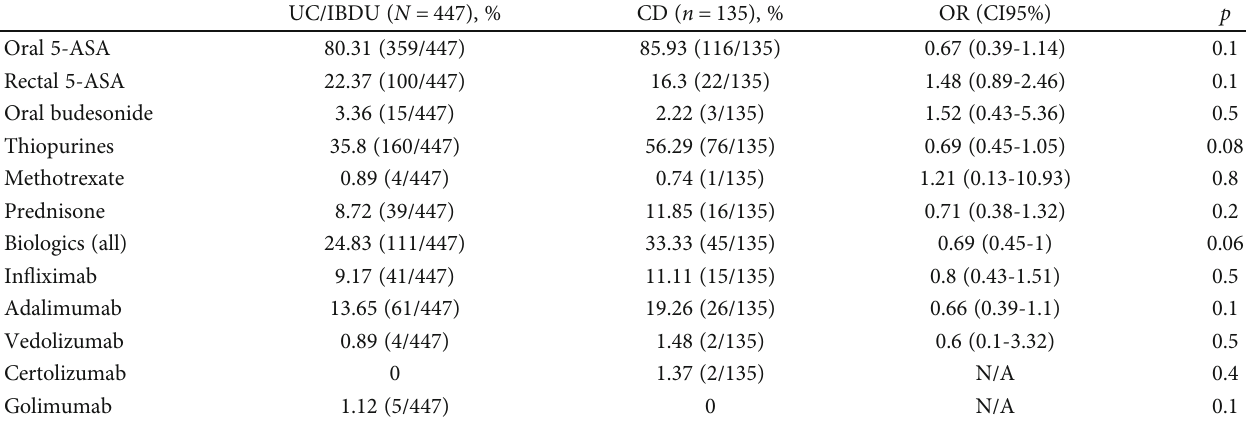
Table 2: Comparative use of chronic medications between enrolled UC/IBDU and CD